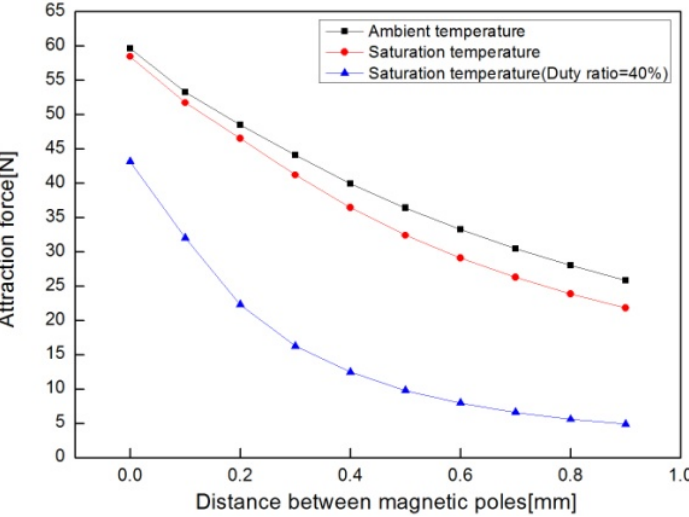
Figure 11. Attraction force for different distances between magnetic poles.